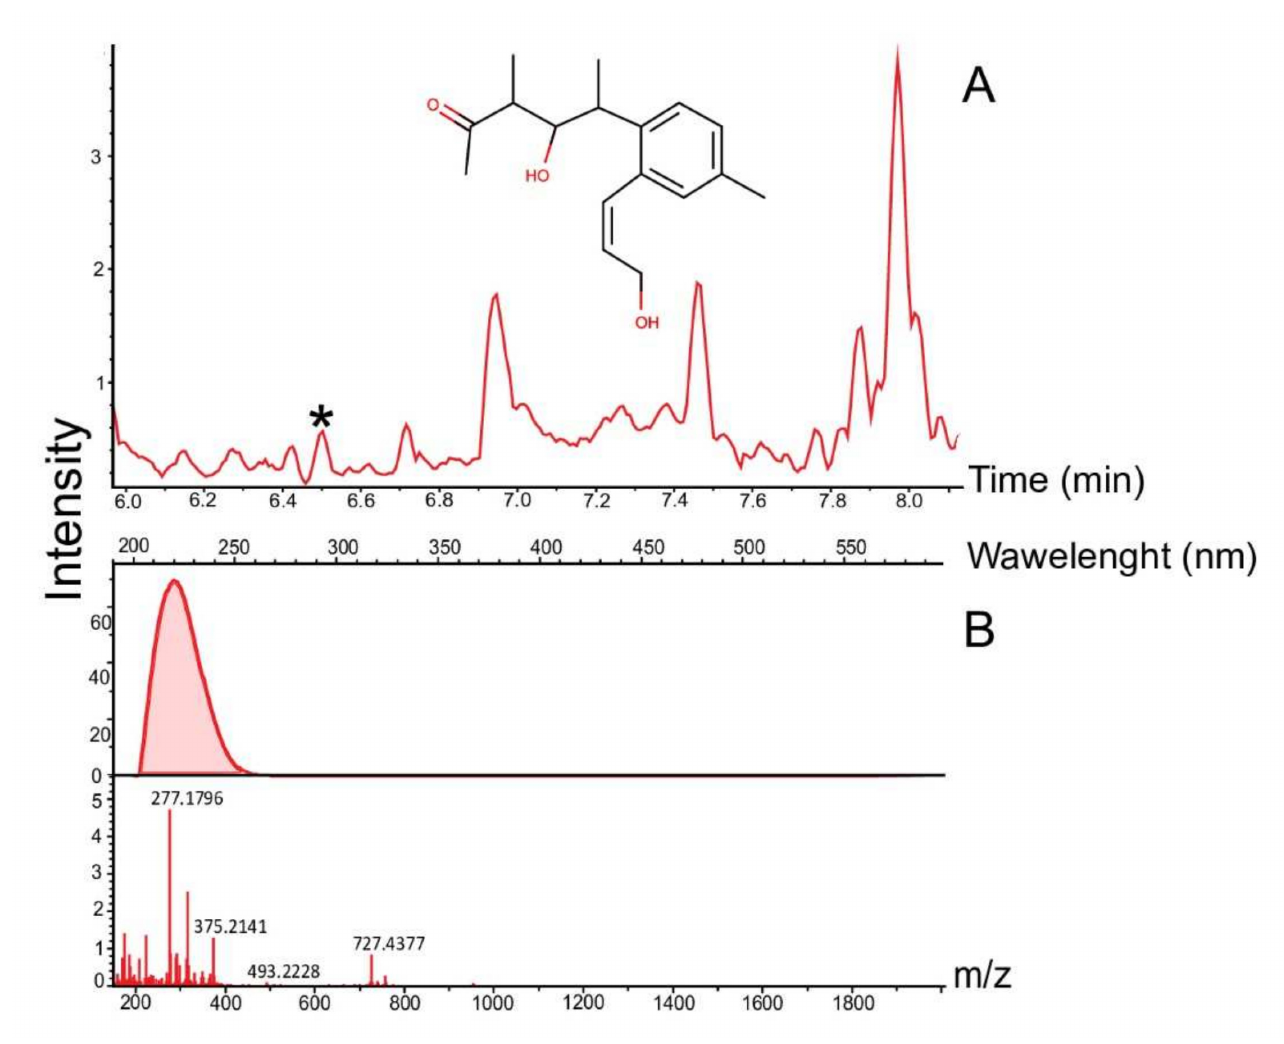
Figure 7. Mass chromatograms of NFAT 133: ( A ) Mass chromatogram of NFAT 133; ( B ) UV and mass profile of the peak identified as NFAT 133. *-asterisk indicates peak of natural